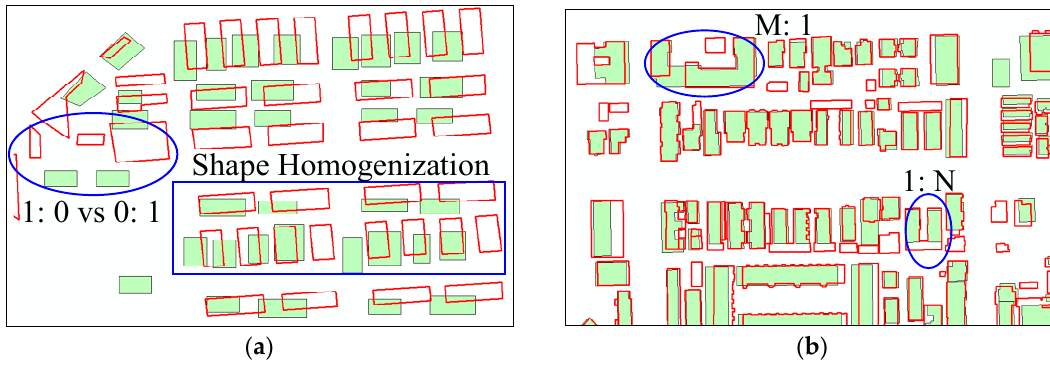
Figure 1b, there are many 1:0, 1:M, N:1, and M:N correspondences with low similarity. Hence, this paper focus on the particular issue of matching multi-scale building polygons with an improved relaxation labelling approach.